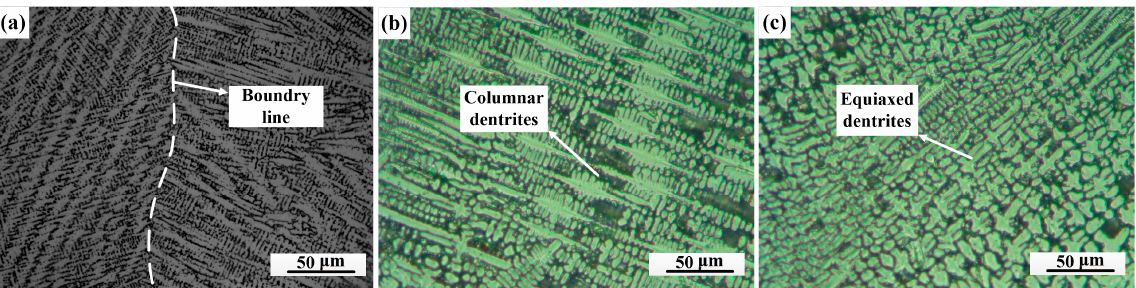
Figure 8. Optical micrographs of weld zones: ( a ) joint 1 and ( b , c ) joint 2.